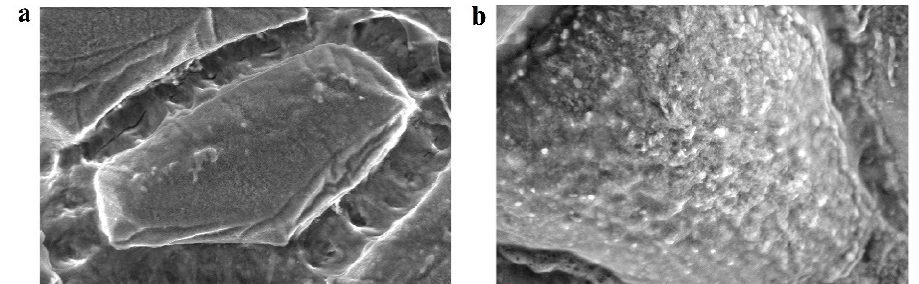
Figure 1. SEM micrographs at 5000× of ( a ) control and ( b ) inoculated Allium cepa